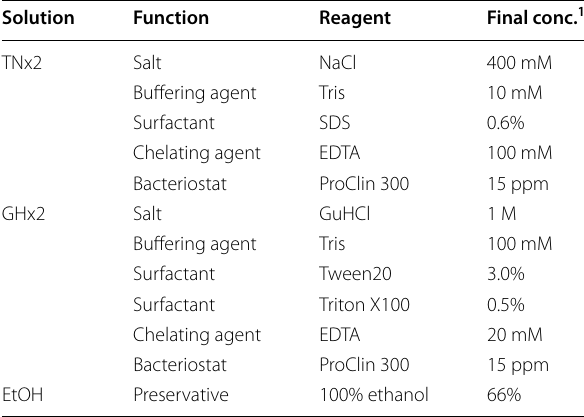
Table 1 Composition and concentration of preservation solutions after adding rumen